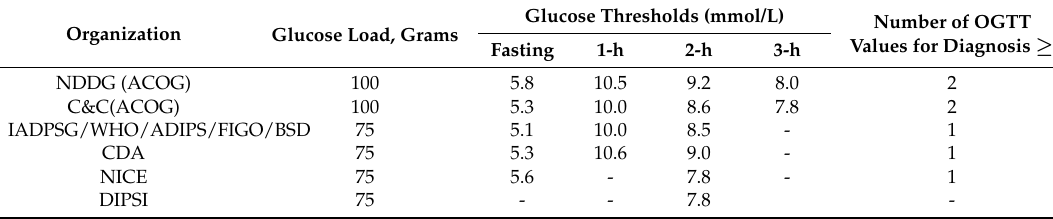
Table 1. Comparison of some current diagnostic criteria of gestational